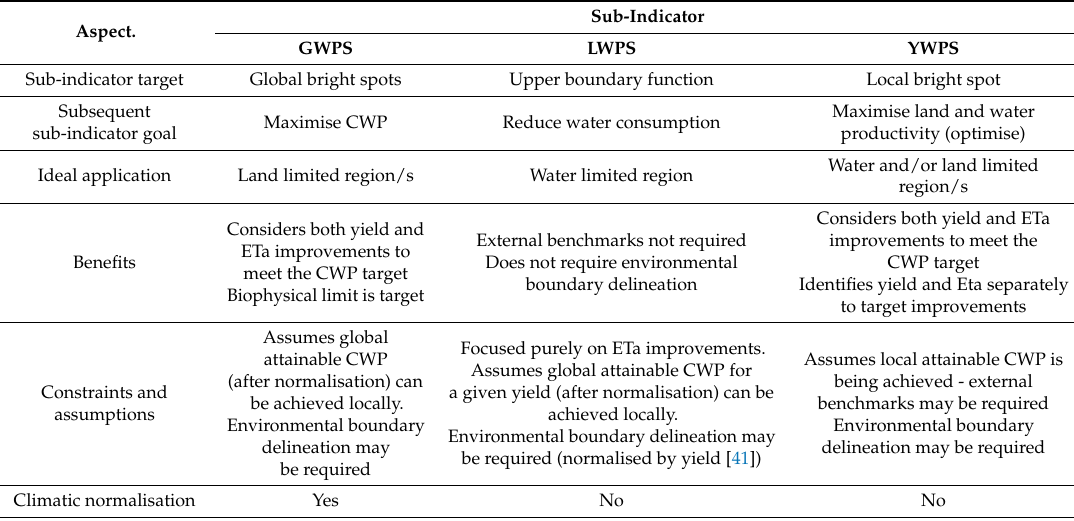
Table 1. Considerations for selecting the appropriate